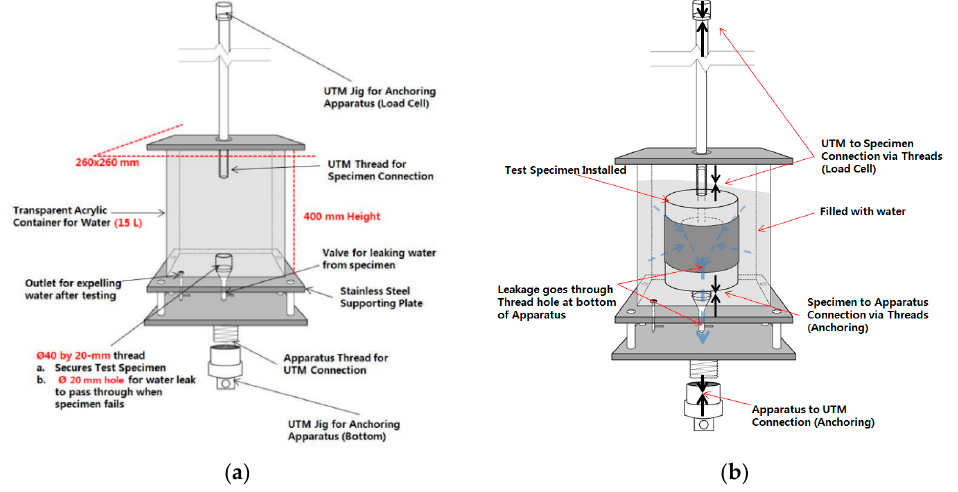
Figure 6. Testing apparatus illustrated ( a ) Container and components; ( b ) Setting in